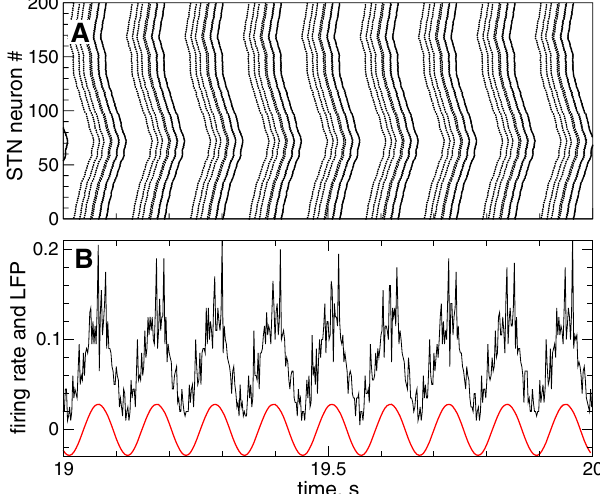
Figure 2. Synchronized dynamics of STN neurons (1) - (3) without stimulation. ( A ) Raster plot and ( B ) firing rate (relative number of neurons firing a spike at a given time) of STN neuronal activity. The red solid curve in plot ( B ) depicts the filtered LFP. The stimulation current I stim = 0 pA/ μ m 2 in equation